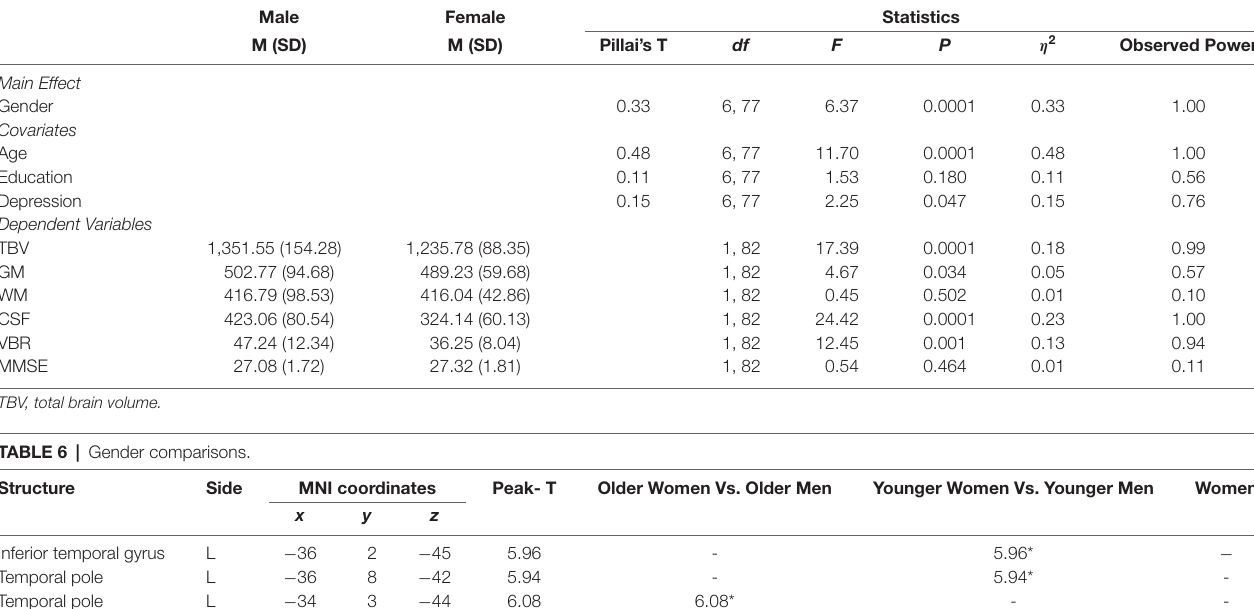
TABLE 5 | Sex differences in brain volume and MMSE, controlling for age, education, and depression.